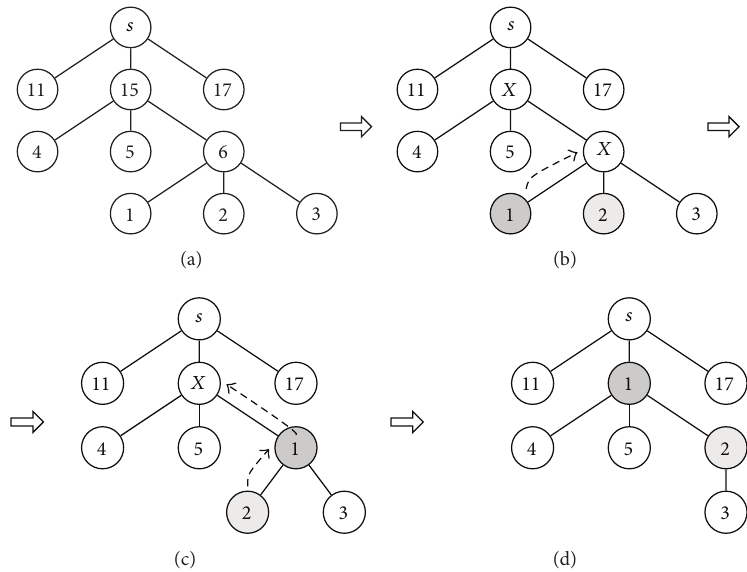
Figure 3: A climbing process: evolution from a Huffman tree (a) to a transmission tree (d) with two intermediate steps: (b) and (c). 𝑡 = 3 , numbers labeling vertices denote peers’ aggravation 𝑝(𝑖)